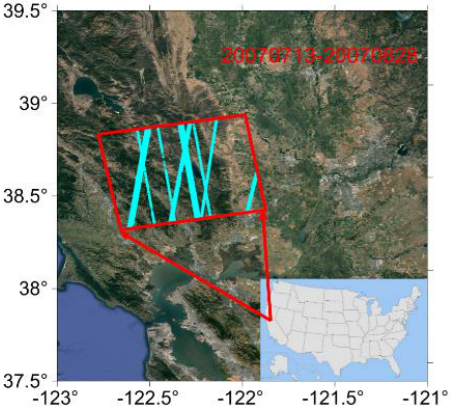
Figure 2. The footprint of the ALOS-1 PALSAR images over the San Francisco region and the spatial coverage of the Ice, Cloud, and land Elevation Satellite/Geoscience Laser Altimeter System (ICESat/GLAS) data over the study area.